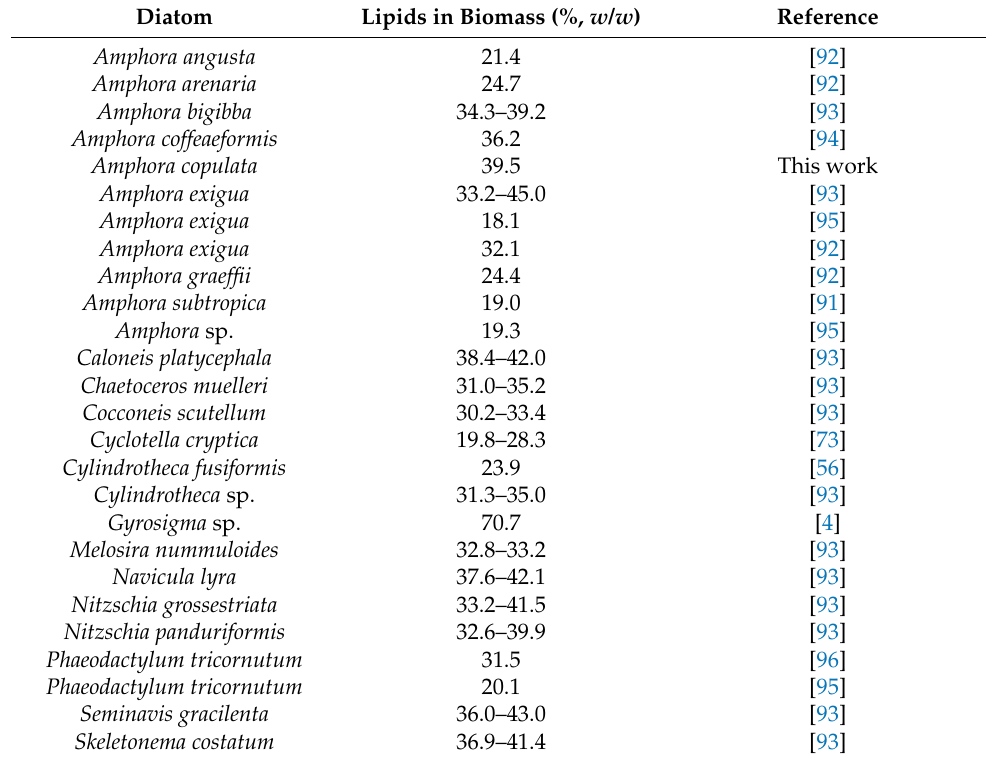
Table 2. Lipid content of some